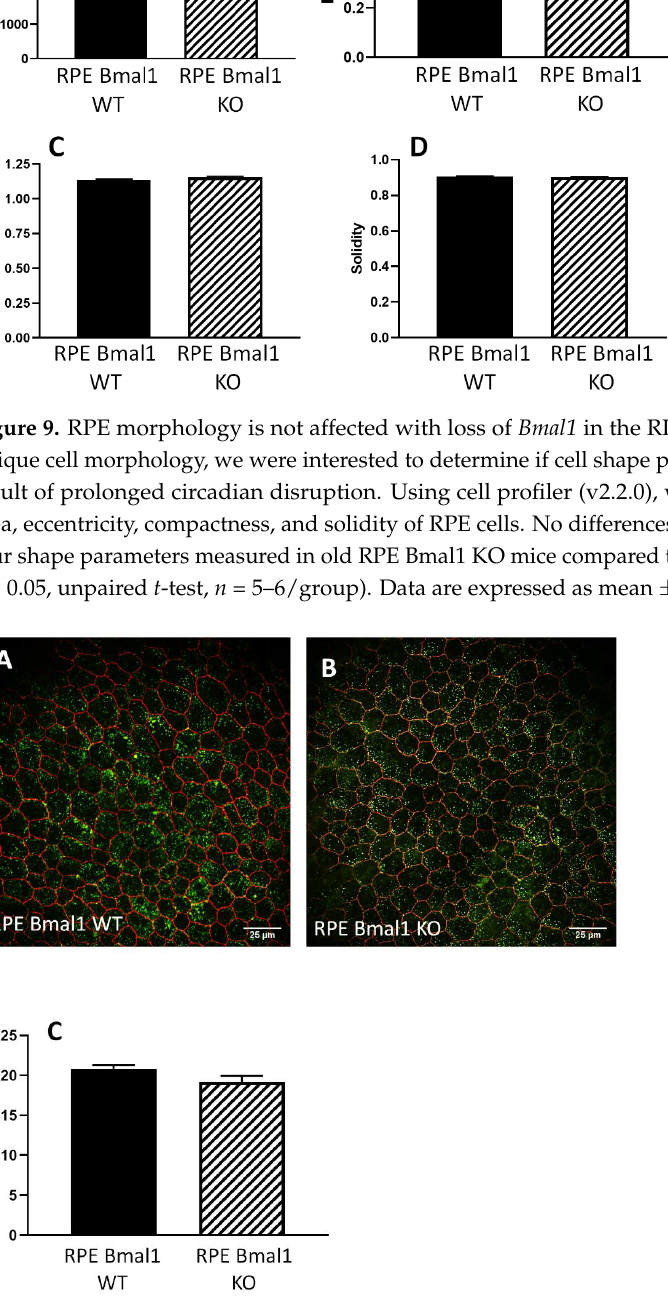
Figure 10. Autofluorescent particle accumulation is not affected by disruption of the RPE circadian clock. We sought to measure the amount of autofluorescence in RPE cells with chronic disruption to the circadian clock in RPE cells. RPE sheets prepared as a flat mount, we quantified the number of apical autofluorescent particles in isolated RPE cells in both old RPE Bmal1 WT mice and RPE Bmal1 KO mice ( A , B ). No differences were observed in the number of accumulated apical autofluorescent particles as a result of the loss of the RPE circadian clock ( C ; p > 0.1, unpaired t -test, n = 5 – 6/group). Data are expressed as mean ± SEM.